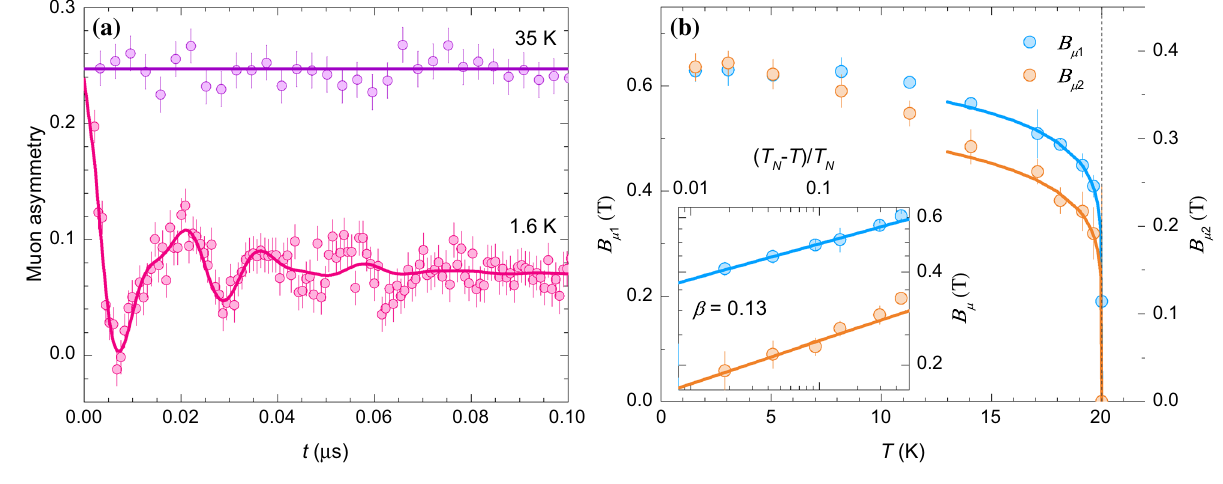
20 K (symbols). The = 0.13 (see =